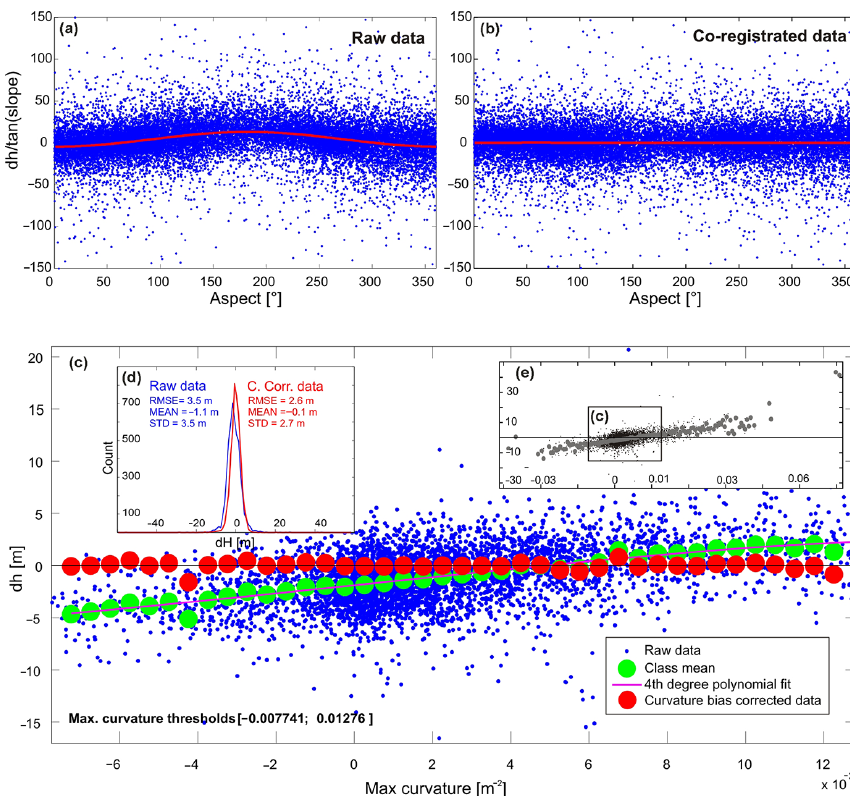
Figure 2. 3-D corregistration and curvature correction of the DEMs. (a) Elevation changes normalized by the tangent of the slope as a function of aspect for off-glacier cells. (b) Same data as (a) after applying the shifts. (c) Curvature correction. Green and red dots show the elevation difference averaged in curvature bins before and after the correction is applied. (d) Histograms of the height differences off-glacier and off-forest, before (blue) and after (red) the curvature bias correction. The RMSE, mean bias (MEAN) and standard deviation (STD) for each data set are shown. (e) Same as (c) but with all elevation data available. Note that most of the data are between the thresholds where the curvature bias correction